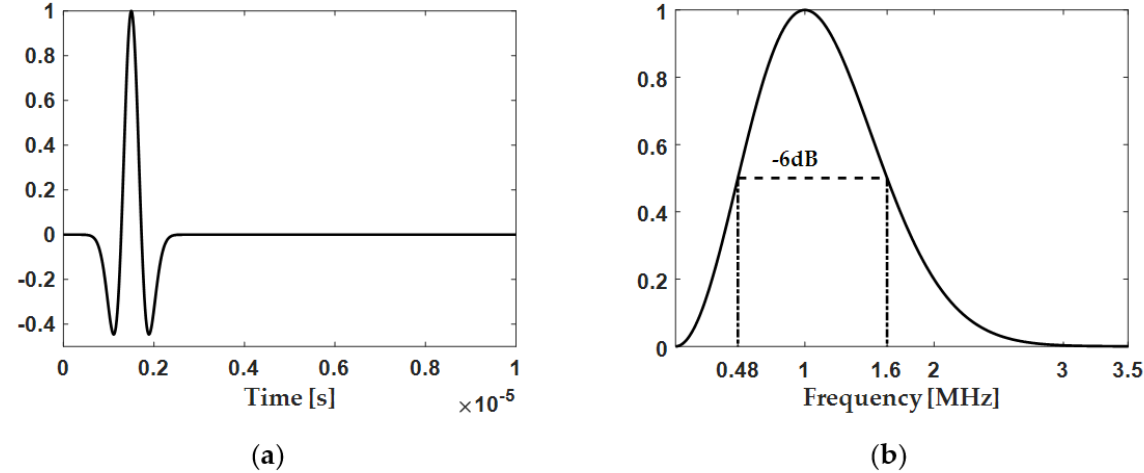
Figure 4. Excitation signal ( f c = 1 MHz and t 0 = 1.5/ f c ). ( a ) Waveform in the time domain and ( b ) the corresponding normalized amplitude spectrum.